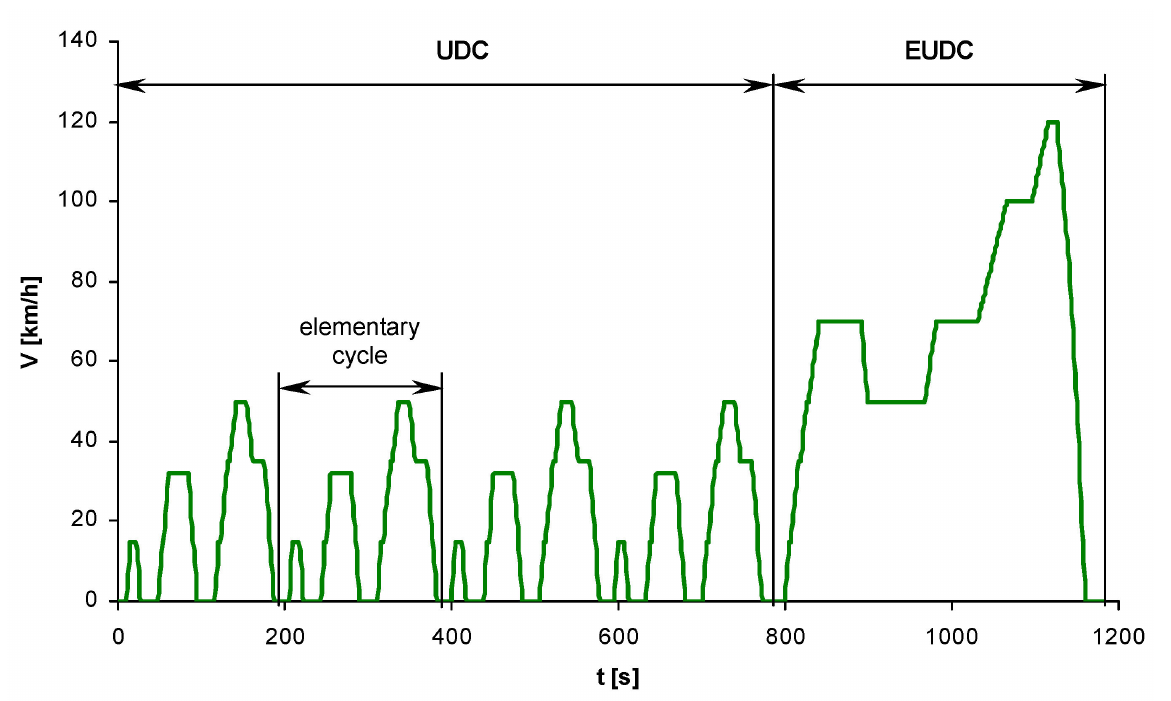
Figure A1. The New European Driving Cycle (NEDC); distance: 11.007 km, duration: 1180 s, average speed: 33.6 km/h; NEDC consists of two phases: UDC (Urban Driving Cycle) and EUDC (Extra Urban Driving Cycle).